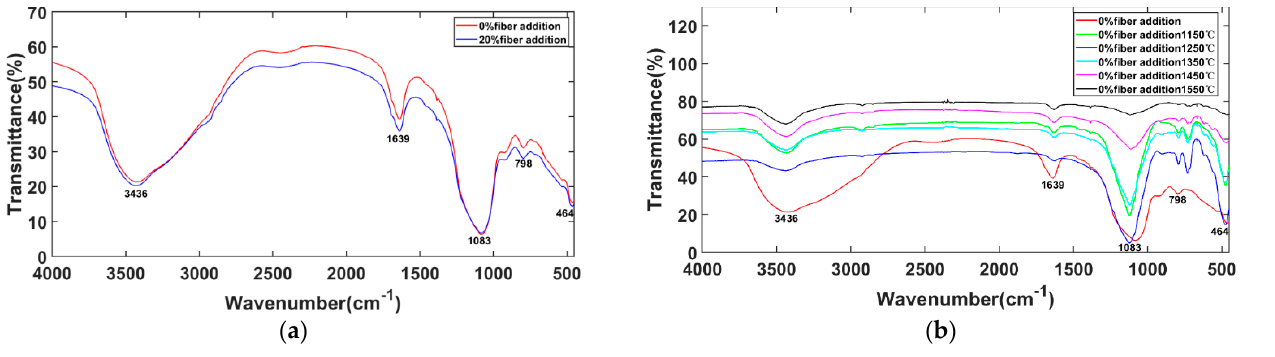
Figure 7. Infrared spectra of geopolymers treated with different fiber ratios and temperatures. ( a ) FTIR spectrums of 0% fibre and 20% fibre without heat treatment; ( b ) FTIR spectrums of 0% fibre with heat treatment at various temperature.